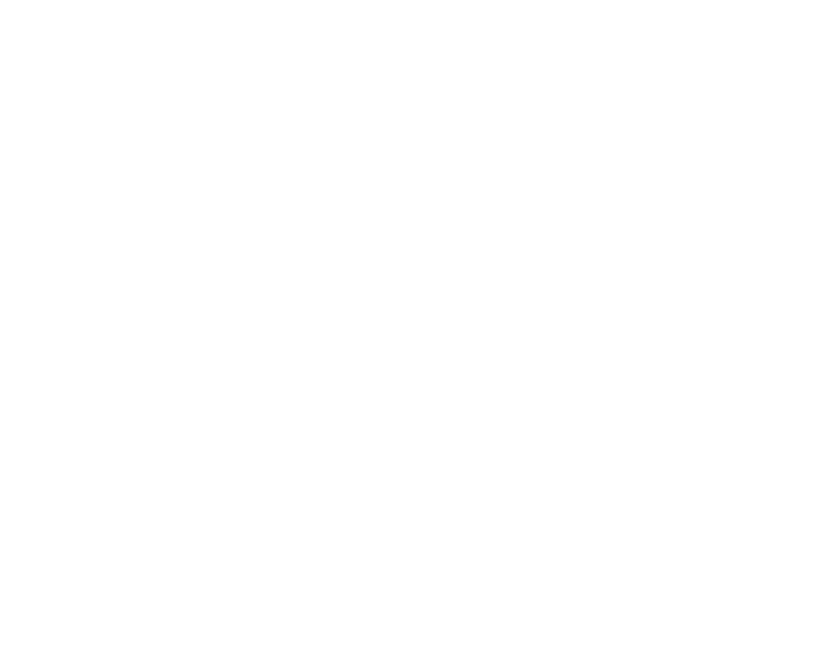
FIGURE A3 | Oxygen influence on NO reduction activity; oxygen ( (cid:4) ), NO ( • ), and N 2 O ( (cid:2) ) concentrations during experiment with 13% initial gas phase oxygen and 0.2mM nitrite. Oxygen addition is performed after 43h and leads to immediate increase in NO reduction, as identified from NO decrease and N 2 O